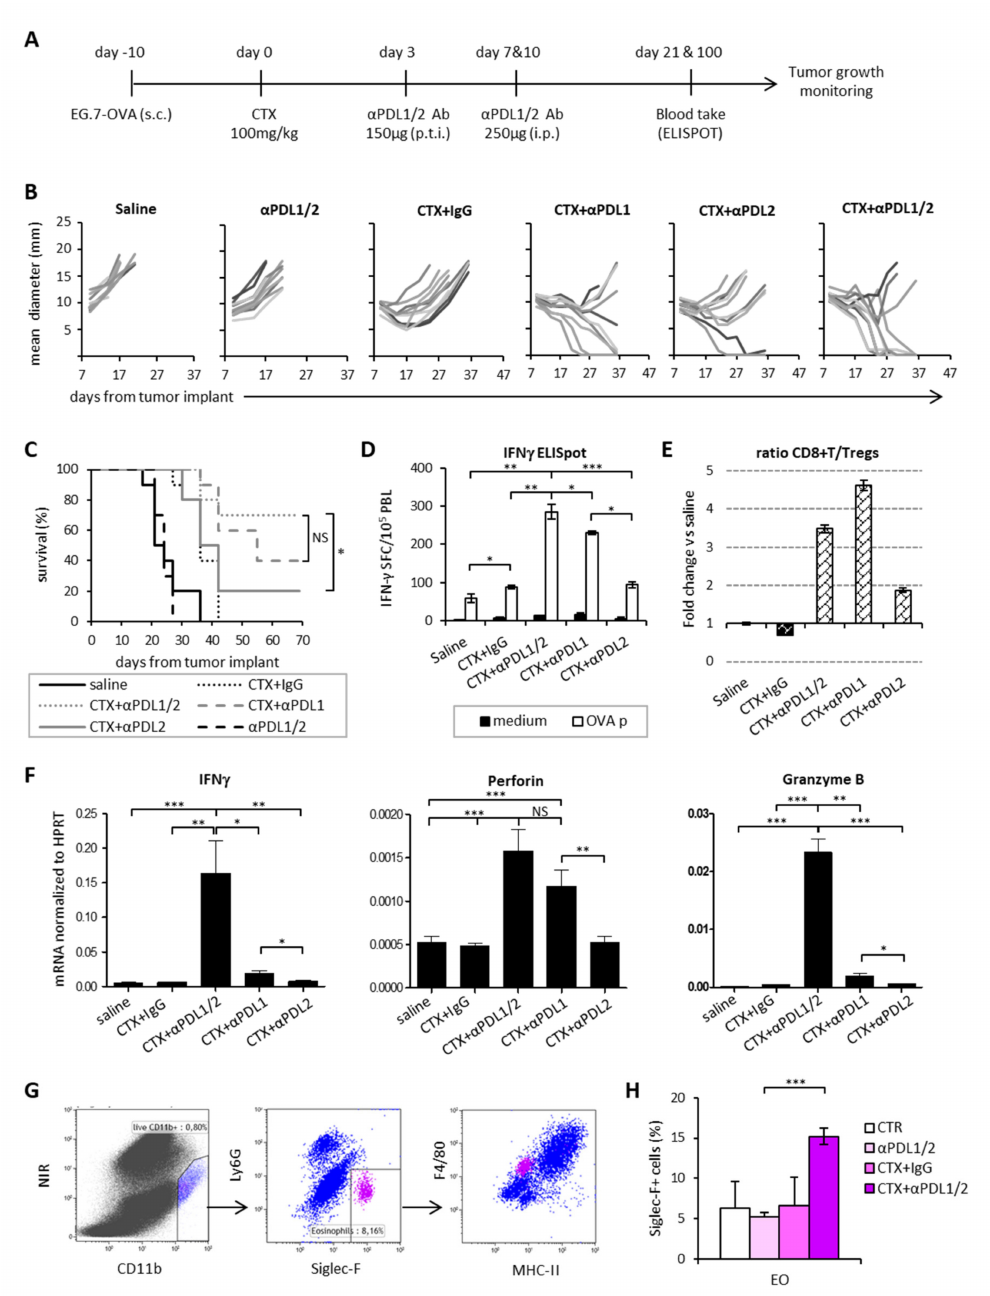
Figure4. ConcomitantPDL1andPDL2blockadesynergizeswithCTXfortumorrejection. (A) Schematic representation of the experimental design. (B) Mean tumor diameter of individual mice in each experimental group ( n = 10). (C) Percentage of surviving mice in each experimental group ( n = 10). (D) Frequency of IFN γ secreting blood leucocytes (PBL) collected on day 21 from treatment initiation and stimulated with MHC class I-restricted OVA peptide (OVA p) or medium as control ( n = 10). Data are expressed as mean ± SEM. (E) CD8 + T / Tregs ratio in tumor microenvironment expressed as fold change versus saline-treated animals ( n = 5). Tumor masses were explanted on day 14 from treatment initiation and processed as described in Materials and Methods section. Tumor infiltrating lymphocytes (TIL) were plotted after gating on viable FSC low SSC low CD45 + cells. Data are expressed as mean ± SEM. One representative experiment out of two with similar results is